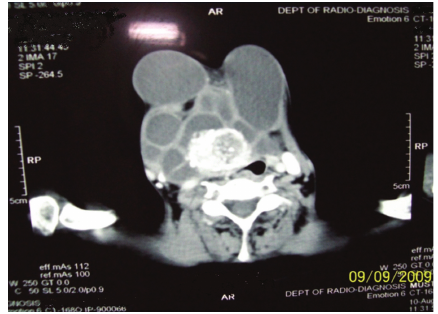
Figure 3: Computer tomaographic image showing multiple cysts arising from right lobe of thyroid.